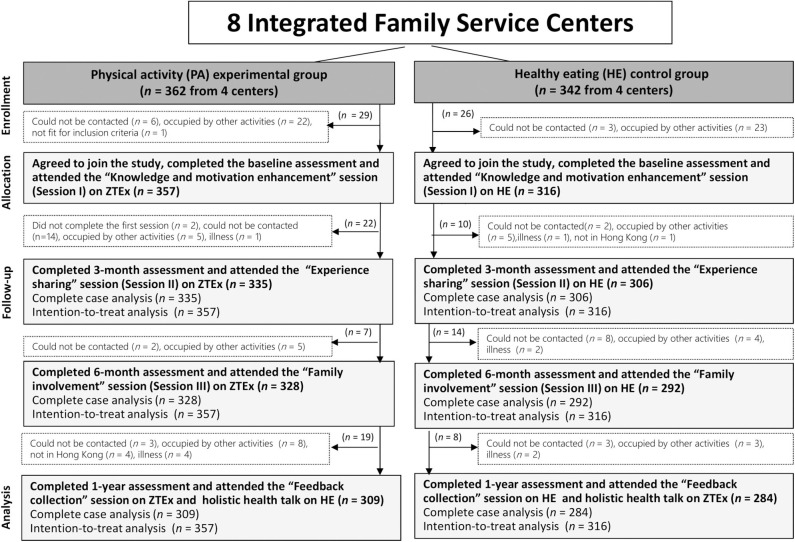
Flow of participants.